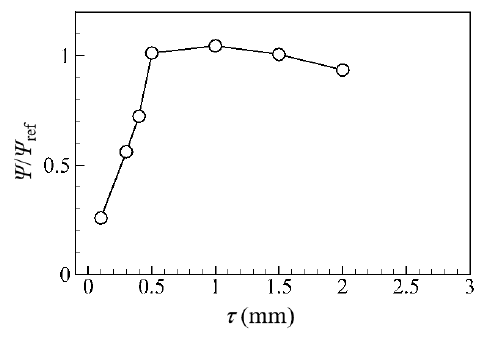
Figure 9. Cavitation performance for different clearances at the designed operation condition. The designed operation condition is at a rotating speed of 5000 r/min and a mass flow rate of 17.3 kg/s, while the inlet pressure and cavitation number are 27,000 Pa and 0.12,